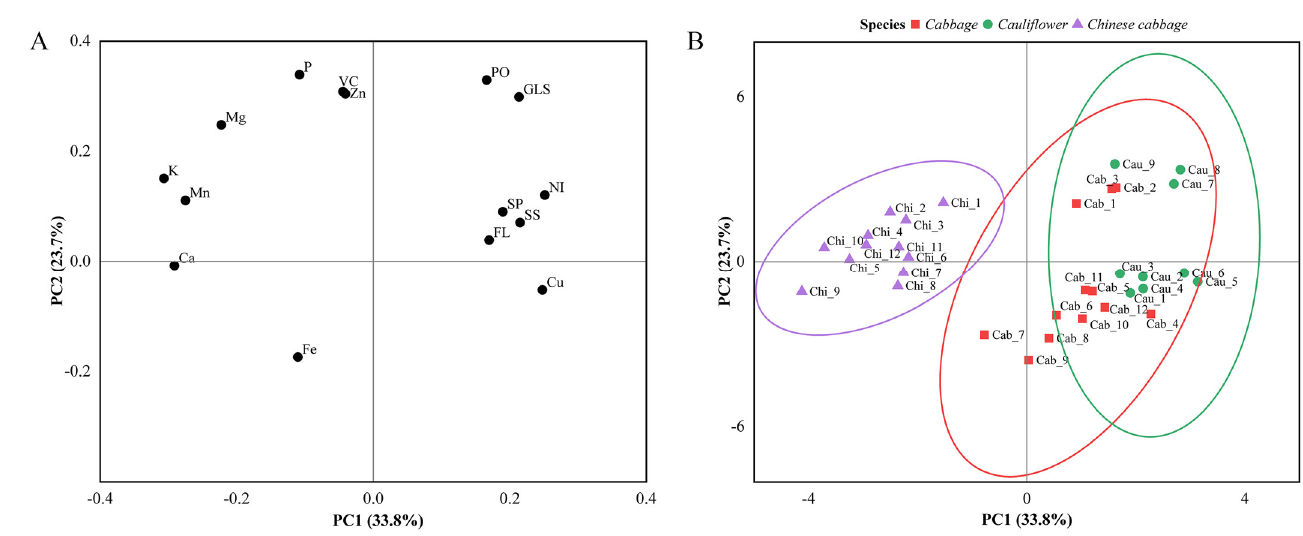
Figure 3. PCA loading plots ( A ) and score plots ( B ) evaluated in this study based on the first two principal components. The first and second principal components account for 33.8% and 23.7% of the total variation, respectively. Depending on the species, these materials are represented by different symbols and colors: the red squares represent cabbage; the green circles represent cauliflower; and the purple triangles represent Chinese cabbage. Ellipses group the accessions of each species at a 95% confidence level. The full name of each trait can be found in Table 3.